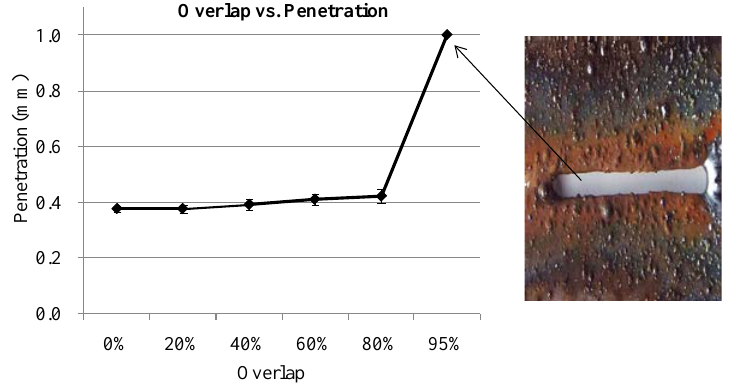
Figure 11. Effects of overlap on weld penetration.